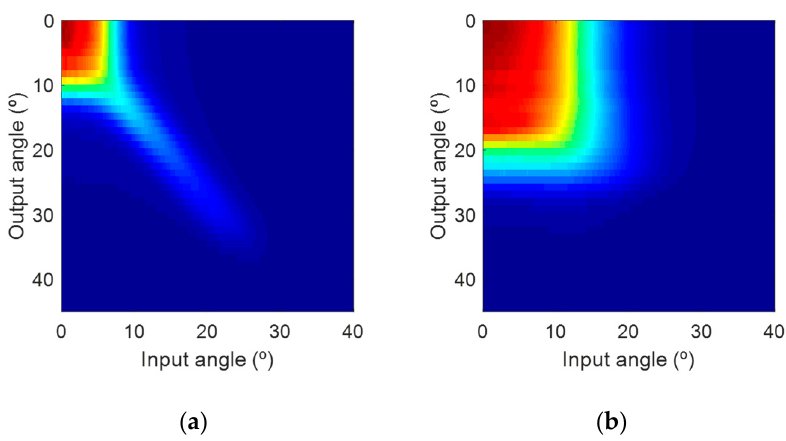
Figure 6. Input–output optical power spatial distributions obtained from far-field pattern scans: ( a ) 2 m GH fiber; ( b ) Y-coupler.